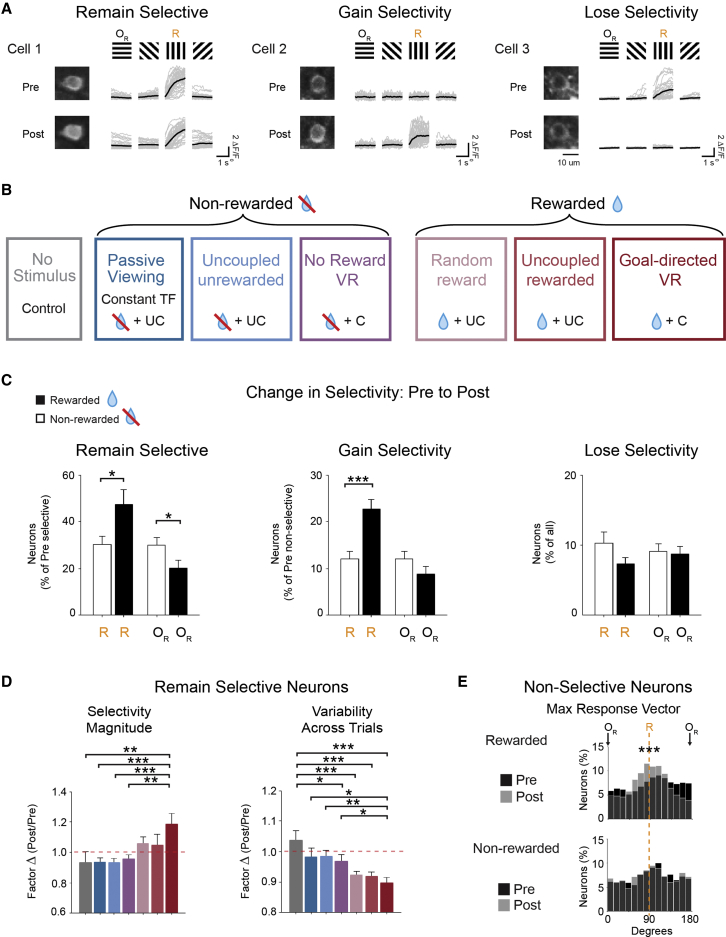
Stimulus-Reward Association Increases Selectivity and Decreases Trial-by-Trial Variability(A) Responses (ΔF/F0) to the four oriented gratings for three example neurons before (pre) and after (post) 5 days of repetitive stimulus presentation are shown for neurons that either remain selective (left), gain selectivity (middle), or lose selectivity (right) for the stimulus that was repetitively presented (R). Individual trials are shown in gray and average response across trials in black.(B) Experimental groups depending on reward association and visuomotor coupling during the repetitive visual stimulus over 5 days. Rewarded and non-rewarded groups are indicated. Visuomotor feedback was either coupled (C) or uncoupled (UC).(C) Proportion of the total number of neurons that are selective for the R grating or the total number of neurons that are selective for the OR grating on the pre testing day for the rewarded (black) and non-rewarded (white) groups that then either remain selective (left; R, p = 0.016; OR, p = 0.0421) or gain selectivity (middle; R, p < 0.001; OR, p = 0.144) by the post testing day. Proportion of the total number of all neurons in the rewarded (black) and non-rewarded (white) groups that then lose (right; R, p = 0.093; OR, p = 0.816) selectivity for the R or the OR grating is shown. For all, n = 27 mice; Student’s t test.(D) Factor change in the magnitude of selectivity (preferred orientation response vector; left; p = 0.006, one-way ANOVA with LSD test; ∗∗p < 0.01; ∗∗∗p < 0.001) and in the variability of the selectivity across trials (as measured by the coefficient of variation; right; p = 0.004, one-way ANOVA with LSD test; ∗p < 0.05; ∗∗p < 0.01; ∗∗∗p < 0.001) on post day compared to pre day (post/pre) for the population of neurons that remain selective for the R grating for each experimental group in (B). Red dashed line represents no change from pre to post.(E) Distribution of the preferred orientation (maximum response vector in degrees) for the individual neurons that remain non-selective from pre (black) to post (gray) testing day for rewarded (∗∗∗p < 0.001; Kolmogorov-Smirnov test) and non-rewarded (p = 0.914; Kolmogorov-Smirnov test) groups. For each condition, both distributions are overlaid to show the changes between pre and post days. Dashed line represents the orientation of the R grating.All panels, error bars: SEM. See also Table S2.